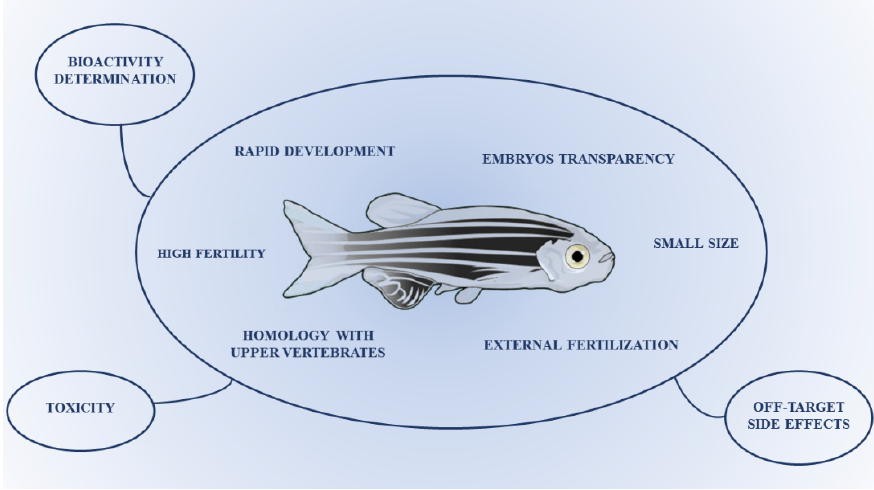
Figure 1. Characteristics of the zebrafish as a valuable model for drug screening and